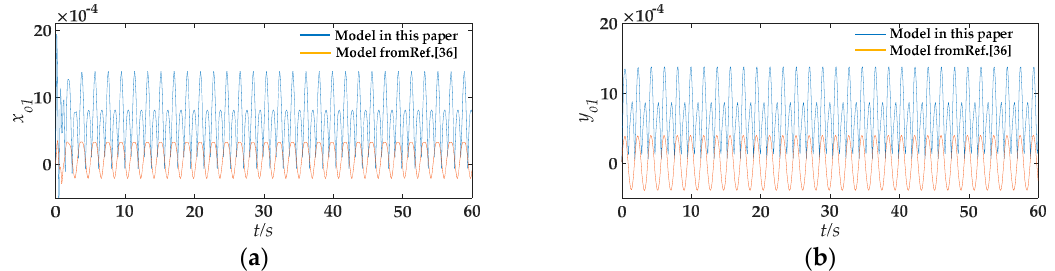
Figure 5. The comparison diagram between the novel nonlinear mathematical model and the previous nonlinear mathematical model. ( a ) Axis coordinate x o 1 ; ( b ) Axis coordinate y o 1 .